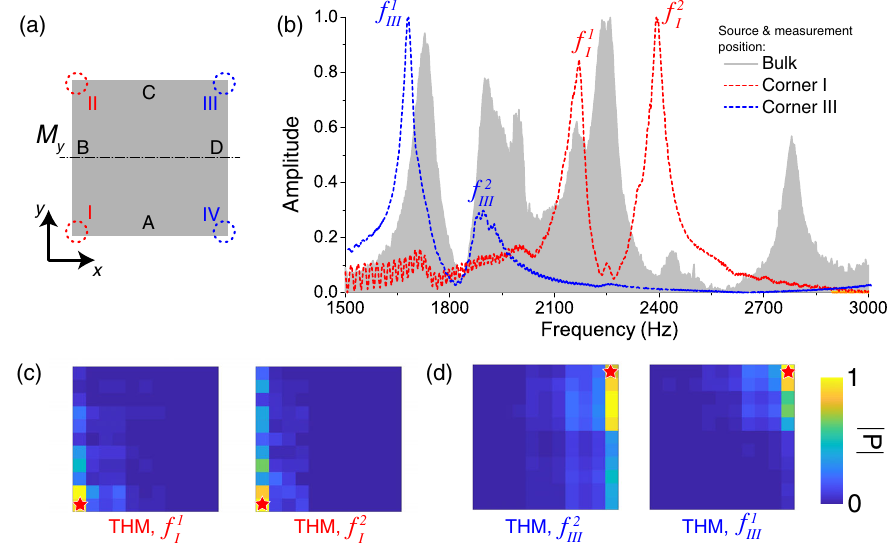
FIG. 7. The experimental results at ð ϕ x ; ϕ y Þ ¼ ð − 0 . 5 π ; 0 Þ . (a) A schematic drawing of the system, with the bulk, edges, and corners marked in different colors. (b) The gray-colored region is pressure response in the bulk; the red and blue dashed curves are, respectively, the response measured at corner I and corner III. (c) The field maps when excited by a source located at corner I at the two frequencies as marked in (b). The distributions suggest THMs are found only at edge B . (d) The field maps at two frequencies from the peak of the corner III response spectrum. The distributions suggest THMs localized at edge D . The red stars mark the source